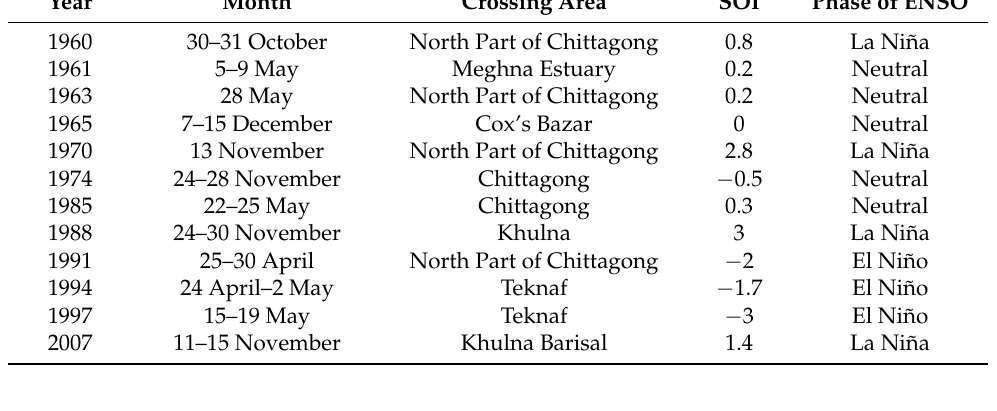
Table 3. Categorizing of major TCs in Bangladesh.